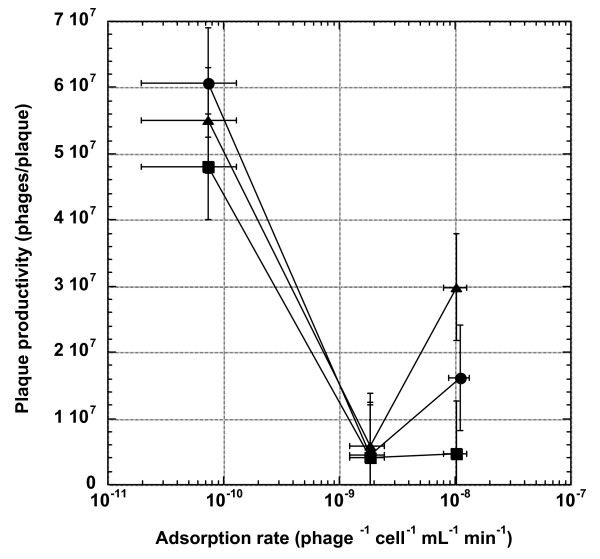
Effect of adsorption rate on phage plaque productivity. Numbers of phages per plaque were plotted against adsorption rates under different top agar concentrations. Symbols: triangles, 0.27% top agar gel concentration; circles, 0.53%; squares, 0.8%. Error bars represent 95% confidence intervals. The data point for HA-Stf phage with 0.53% top agar gel concentration was shifted slightly to the right to increase clarity of the graph.